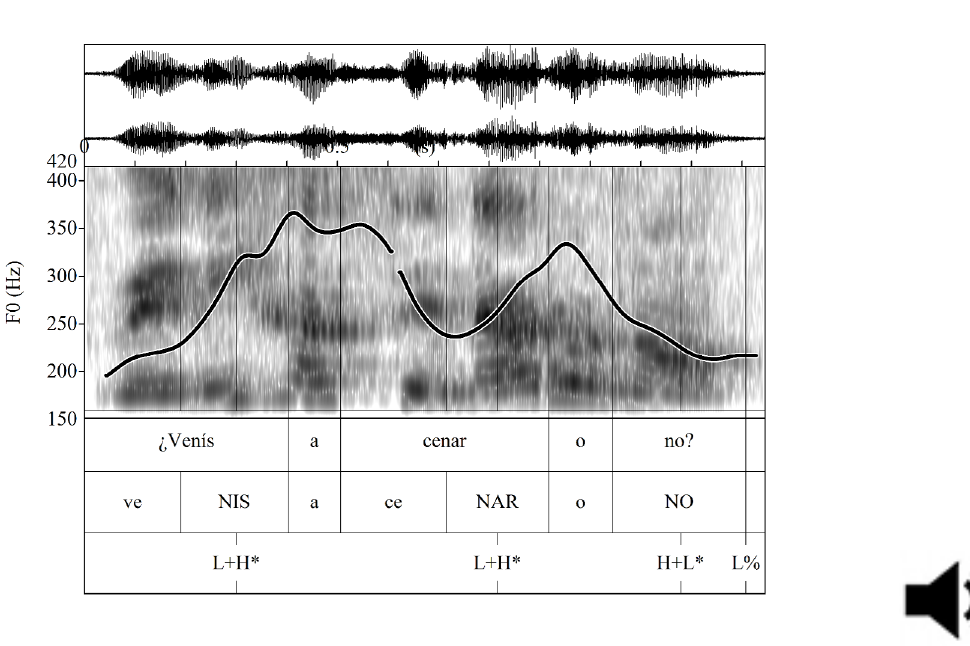
Figure 14 (Participant 3) : Waveform and F0 trace for the confirmatory yes-no question ¿Venís a cenar, o no? ‘Are you coming over for dinner, aren’t you?’ produced as one IP with L+H* in pre-nuclear positions and H+L* L% (nuclear